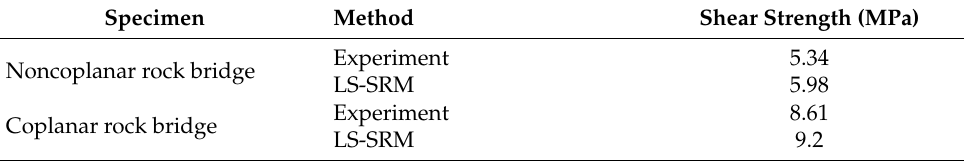
Table 4. Experimental and numerical results on specimens of the noncoplanar and coplanar rock